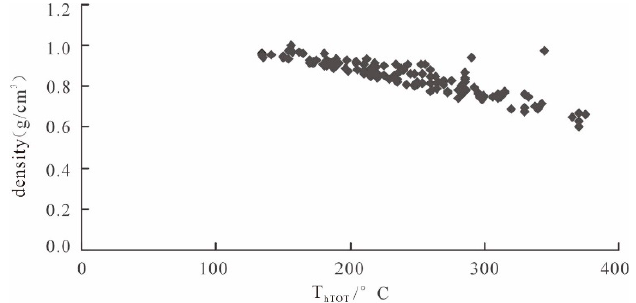
Figure 10. Evolution map of total homogenization temperatures (°C) vs. density of the ore-forming fluid in the Sanshandao gold deposit.